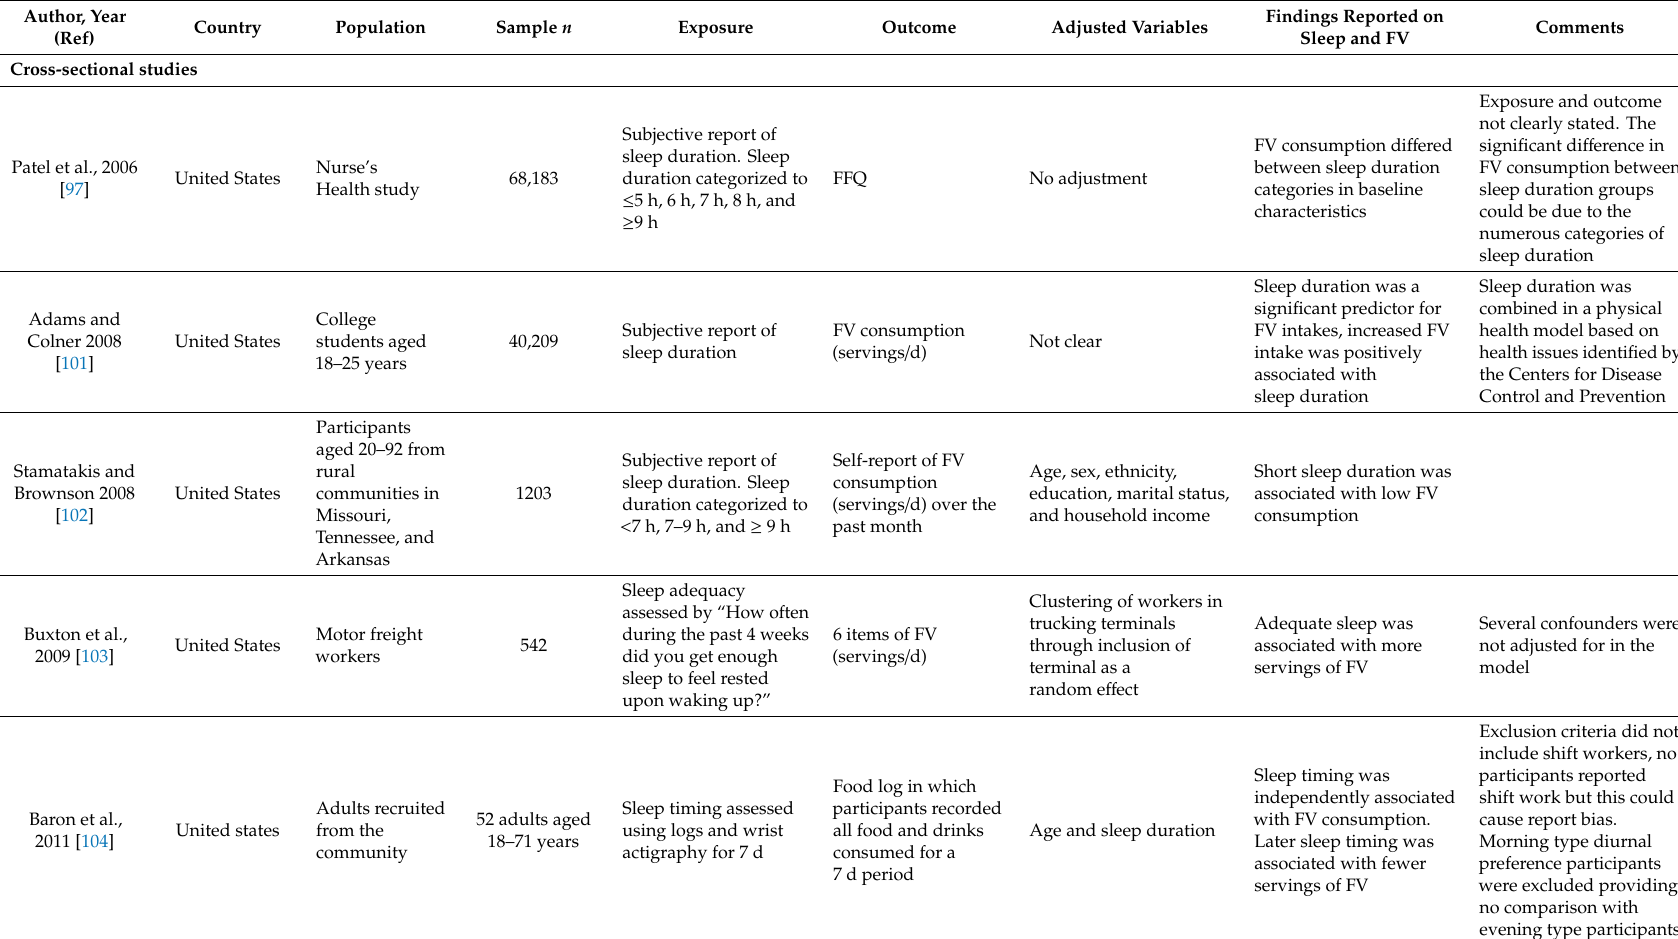
Table 2. Adult human studies assessing the relationship between sleep measures and fruit and vegetable